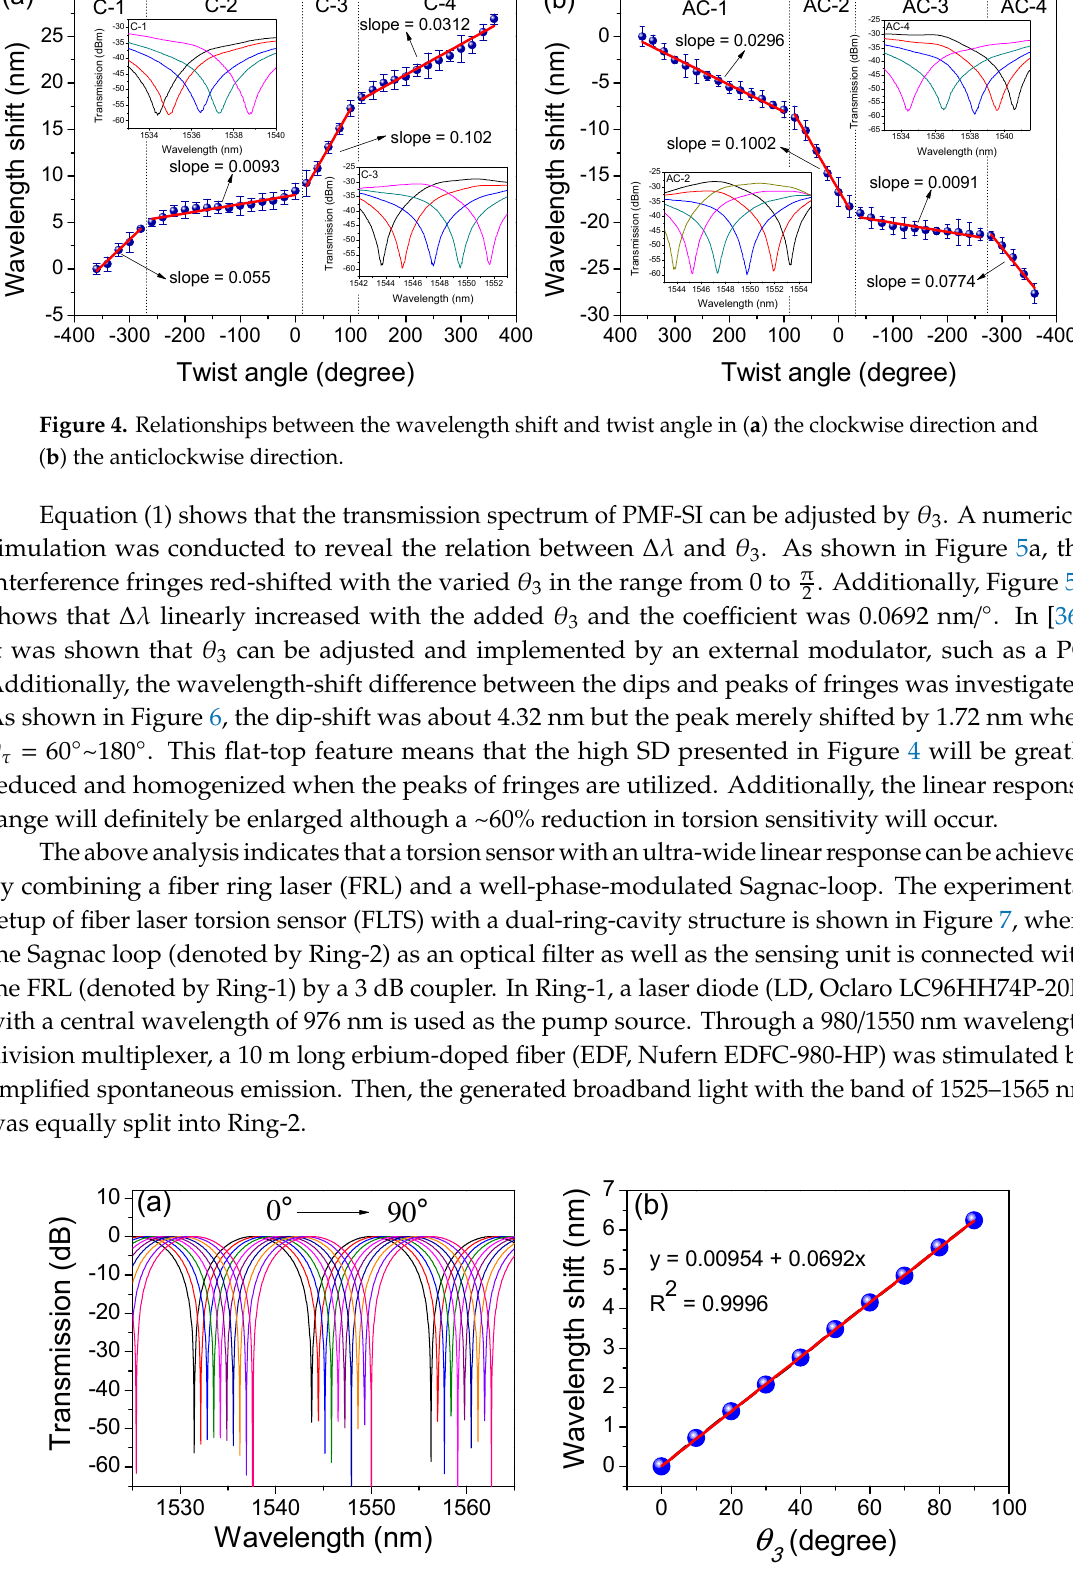
1.72nm Figure 6. Interference fringe peak and dip wavelength shift with the changed 𝜃 (cid:3099) . The above analysis indicates that a torsion sensor with an ultra-wide linear response can be achieved by combining a fiber ring laser (FRL) and a well-phase-modulated Sagnac-loop. The experimental setup of fiber laser torsion sensor (FLTS) with a dual-ring-cavity structure is shown in Figure 7, where the Sagnac loop (denoted by Ring-2) as an optical filter as well as the sensing unit is connected with the FRL (denoted by Ring-1) by a 3 dB coupler. In Ring-1, a laser diode (LD, Oclaro LC96HH74P-20R) with a central wavelength of 976 nm is used as the pump source. Through a